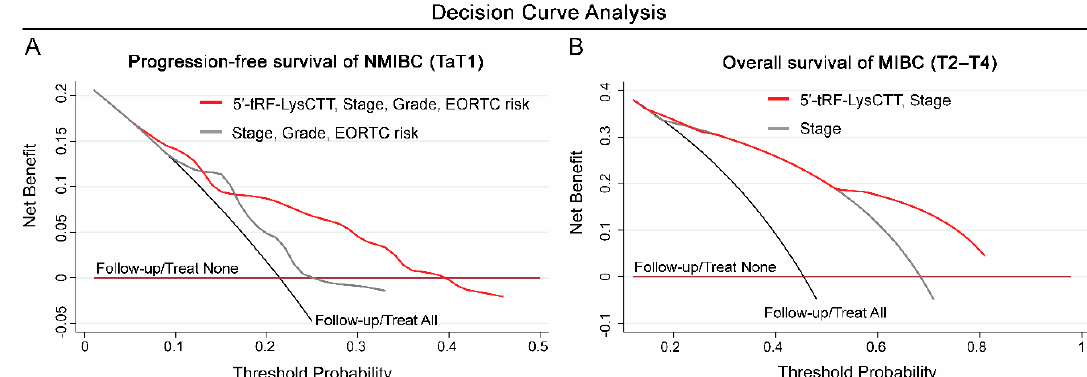
Figure 8. Decision curve analysis highlighted the improved clinical net benefit of multivariate prognosis models incorporating 5 (cid:48) -tRF-LysCTT with established disease clinical markers. ( A , B ) Decision curves of the multivariate prediction models for the progression-free survival of NMIBC (TaT1) patients ( A ) (Red line: 5’-tRF-LysCTT, Stage, Grade and EORTC risk; Grey line: Stage, Grade and EORTC risk; Black line: Follow-up / Treat All; Brown line: Follow-up / Treat None) and the overall survival of MIBC (T2-T4) patients ( B ) (Red line: 5’-tRF-LysCTT and Stage; Grey line: Stage; Black